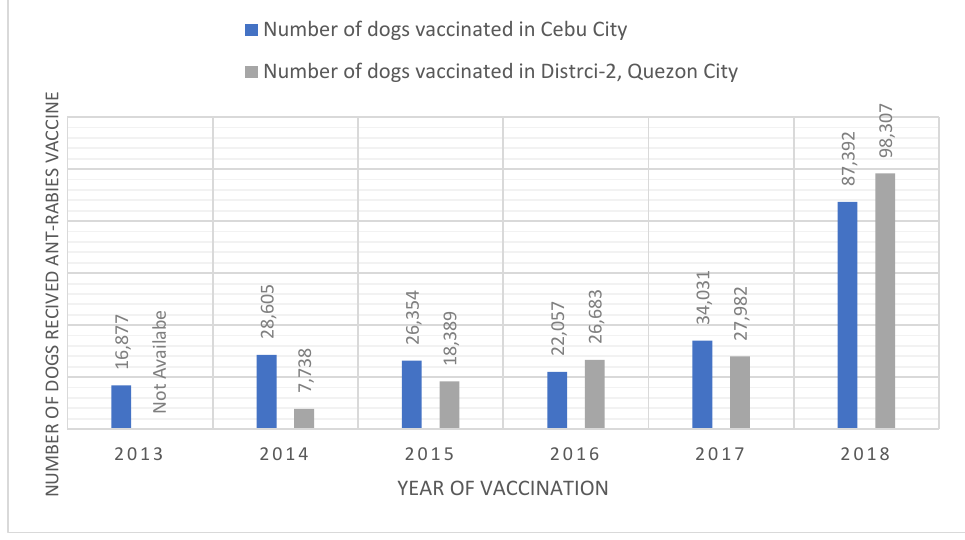
Figure 9. Number of dogs vaccinated between 2013 to 2018 in Cebu City and Quezon City.